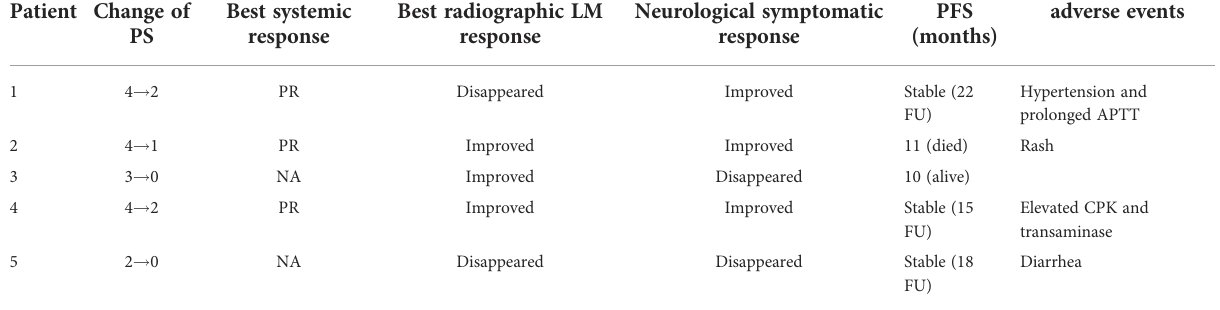
TABLE 2 Tumor responses and disease control.